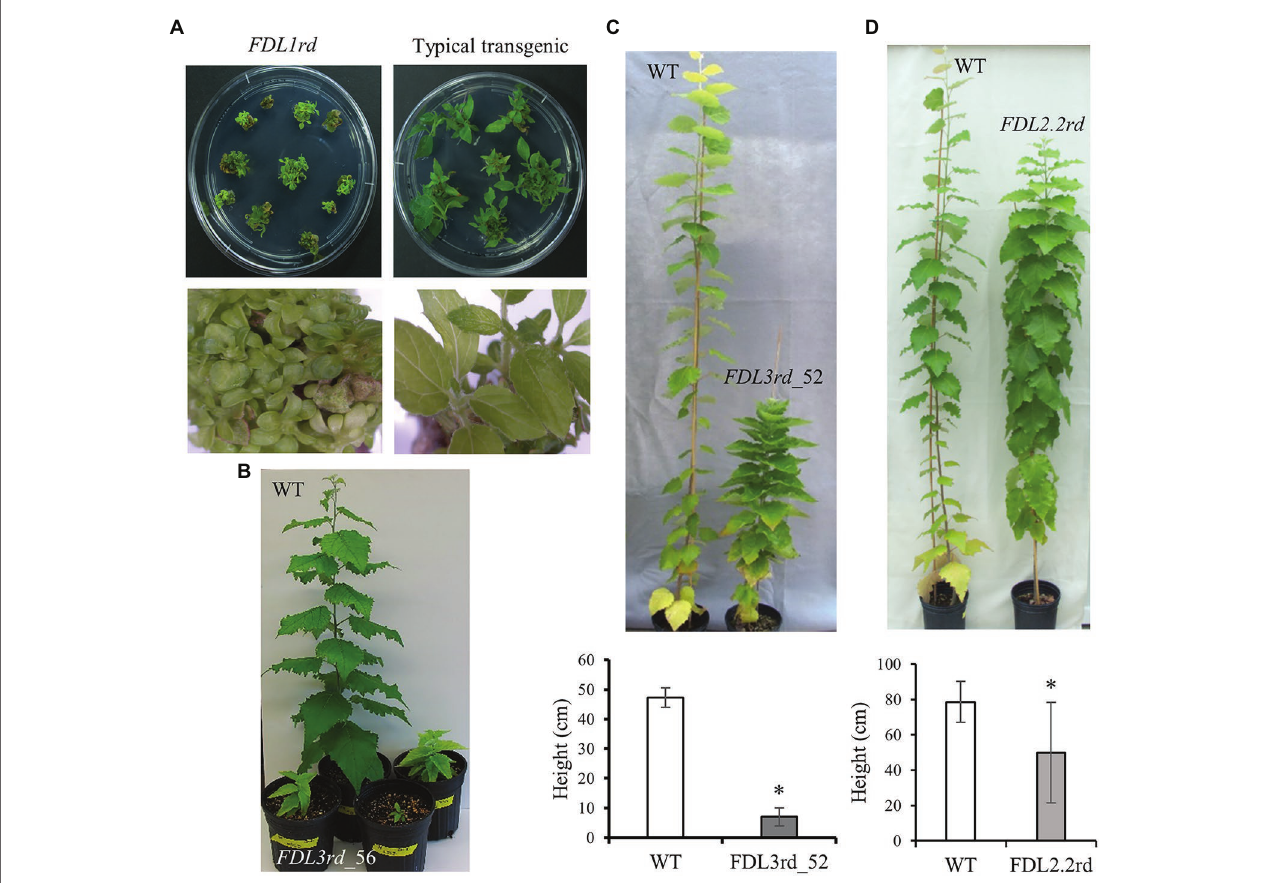
FIGURE 2 | Phenotypic effects of dominant repressor versions of FDL genes. (A) FDL1rd transgenic shoots on shoot elongation medium compared to an unrelated transgenic regenerated at the same time that displays typical shoot elongation. Each clump of shoots corresponds to a single explant that was induced to form callus and then shoots. Bottom photos show shoots from one of the explants in the top photos. (B) FDL3rd_56 transgenics showed reduced shoot growth and set terminal buds within 2 months after potting under LD conditions, whereas WT continued to grow. (C) FDL3rd_52 trees showed reduced shoot elongation. Representative 6-month-old trees are shown and values are means ± SE for two WT and two FDL3rd_52 trees after 3 months of growth in a greenhouse. (D) Representative 6-month-old WT and FDL2.2rd trees and mean heights ± SE after 4 months of growth in a greenhouse. For WT, n = 12; For FDL2.2rd , n = 16 (eight events with two ramets/event). * p < 0.01 compared to